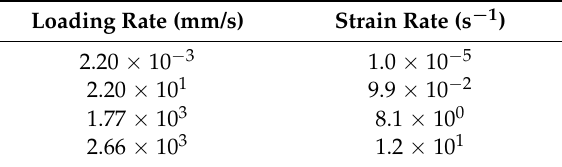
Table 5. Equivalent strain rate for various loading rates.